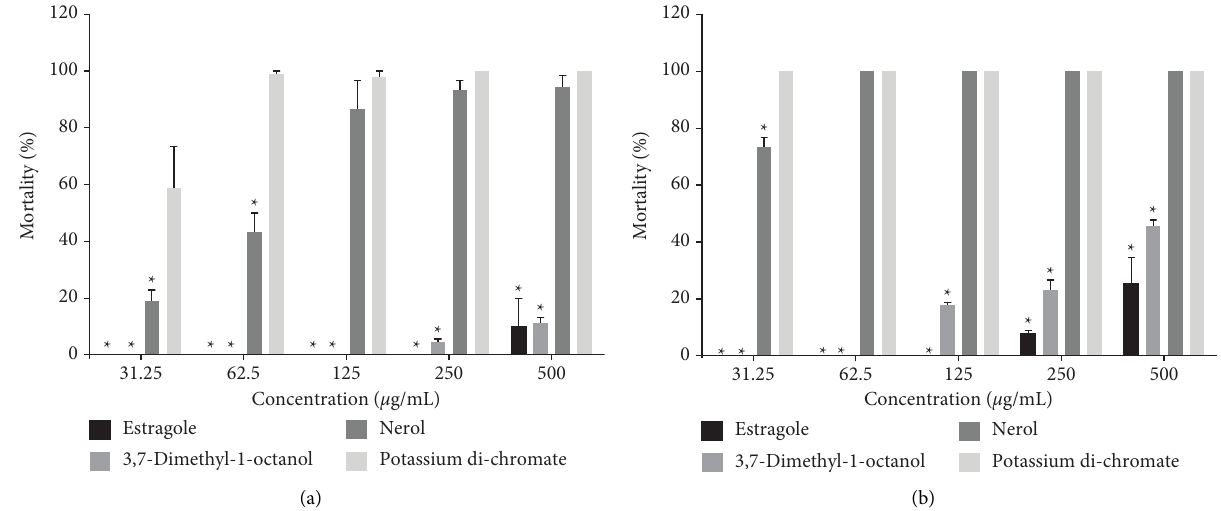
Figure 2: Percentage of Artemia Salina mortality under the monoterpene’s treatment. Notes: Values are mean ± SD of triplicate value. ∗ p < 0 . 05 compared to the NC (vehicle) (ANOVA followed by post-hocNeuman-Keuls test). (a) 24h and (b) 48 h of treatment with nerol, estragole, 3,7-dimethyl-1-octanol and controls. Vehicles represented 0.0% mortality, therefore, omitted from the Table 2: Efects of treatment on hemolytic activity in mouse erythrocytes.